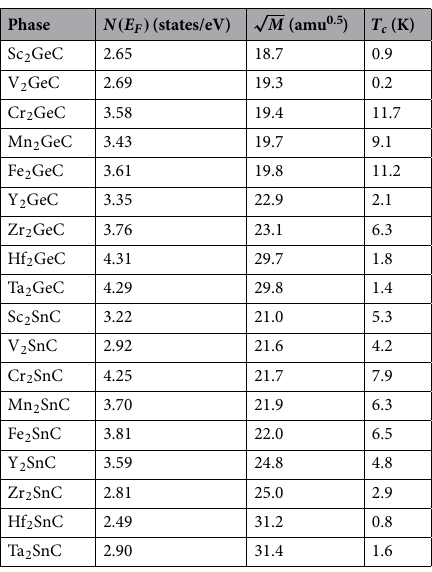
Table 2. Superconducting temperature values of all the different M 2 AC (A: Ge and Sn) phases screened by the high-throughput Fröhlich